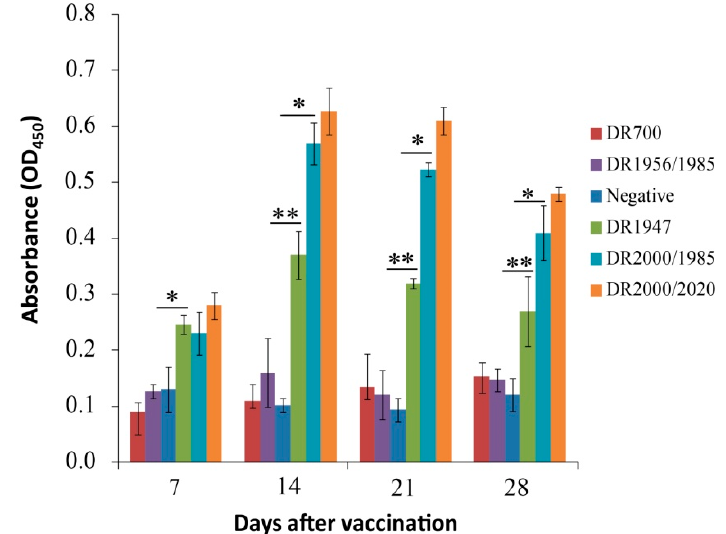
Figure 3. ELISA analysis of the anti-Vp7 IgM titers in the sera of grass carp. Serum samples were collected on the indicated days post oral vaccination. The results represent the means and standard deviations from three independent experiments. The comparison between the DR1947 group with the Naive group or the DR1956/2020 group was shown. Values that were significantly different from the control were indicated by asterisks (* p < 0.05, ** p < 0.01).